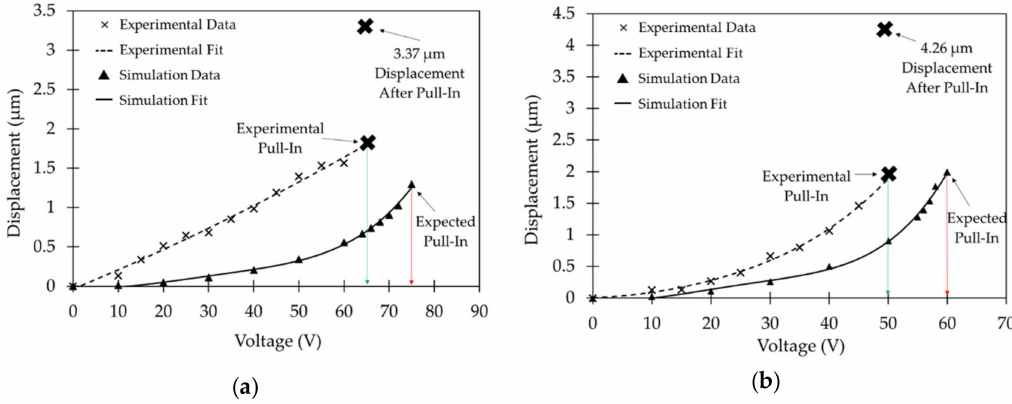
Figure 10. Experimental and simulation based displacement v / s actuation voltage results along with relevant pull-in voltages and maximum displacement obtained for ( a ) the lateral switching actuator; ( b ) the gap closing actuator.